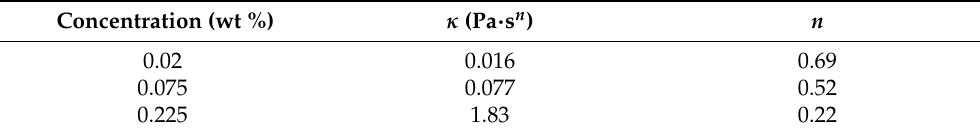
Table 1. Viscosity parametrization for the displaced fluid with different concentration xanthan